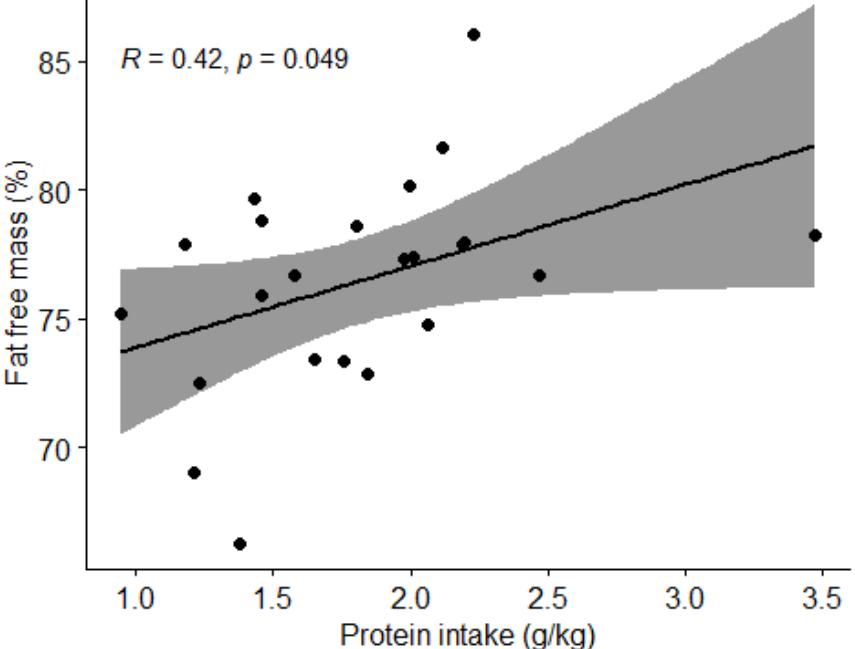
Figure 11. Correlation between protein intake and percentage of lean body mass in football players. Dots represent individual participants ( n = 23). Grey shaded area indicates 95% CI.